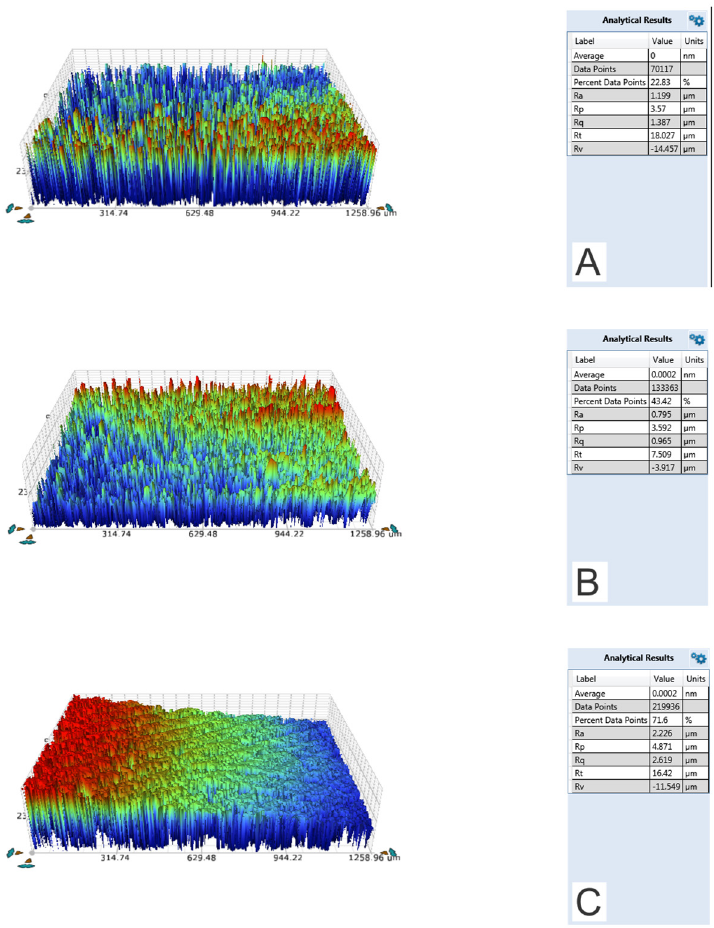
Figure 2. Typical 3D surface profile of non-coated Ti, ALD-HA, and bovine bone slice samples. The surface profiles of non-coated Ti sample ( A ) and ALD-HA surface ( B ) demonstrated a lower surface roughness value compared to the bovine bone slice profile ( C ). Images were captured using a 5 × objective lens and a 0.5 multiplier.